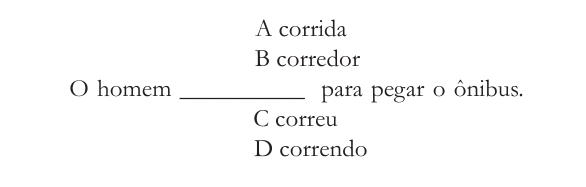
Figura 4. Exemplo de item do teste de derivação por